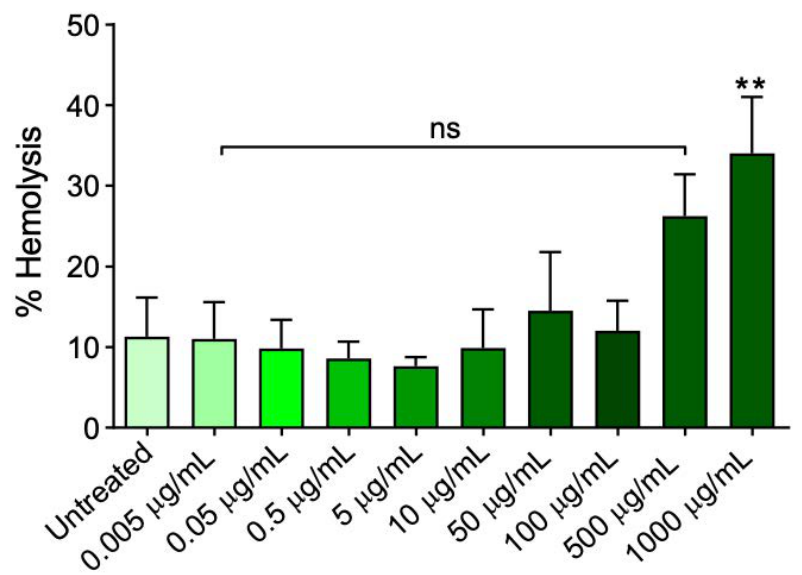
Figure 1. Haemolysis measurement. Human erythrocytes have been exposed to increasing concen- trations of freeze-dried Aça ì extract for 1 h at 37 ◦ C. ns, not statistically significant versus control; **, p < 0.01 versus control, ANOVA with Dunnet’s post-test ( n =